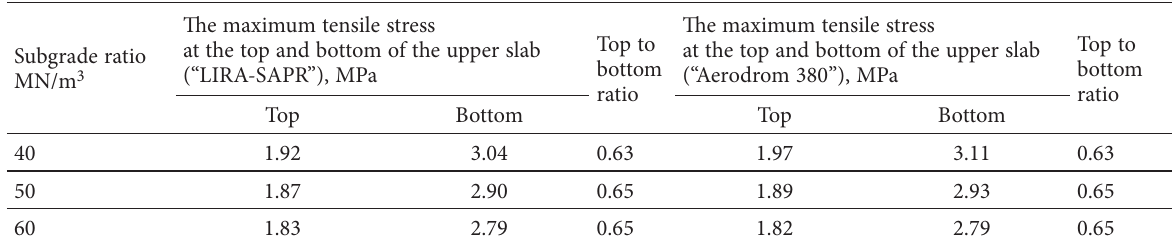
Top to bottom ratio